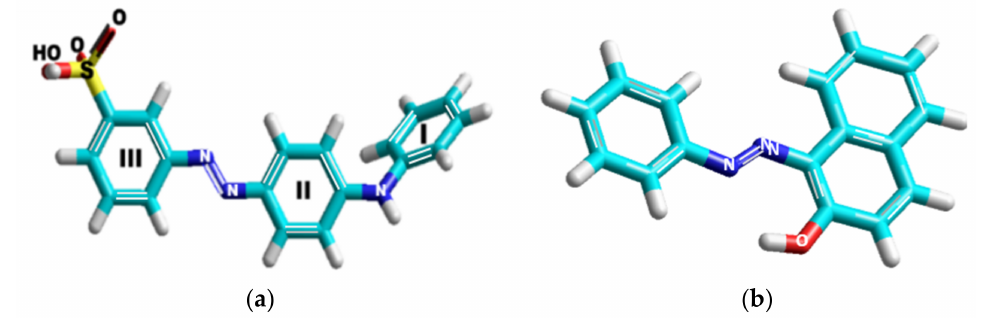
Figure 3. Chemical structure of: ( a ) metanil yellow; ( b )